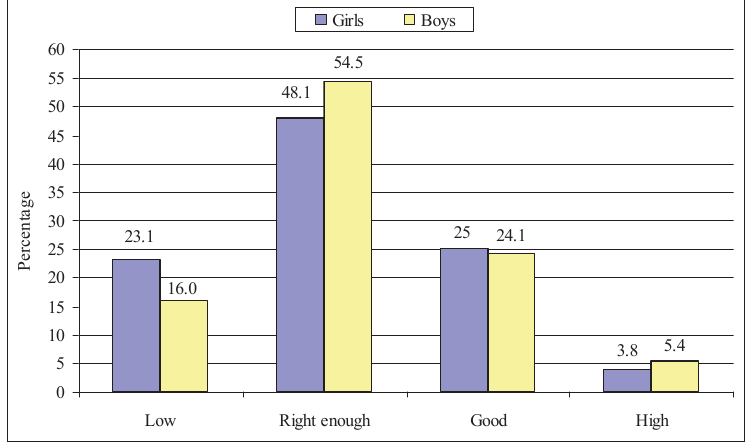
Figure 5. Percentage distribution of physical fi tness level among the girls and the boys